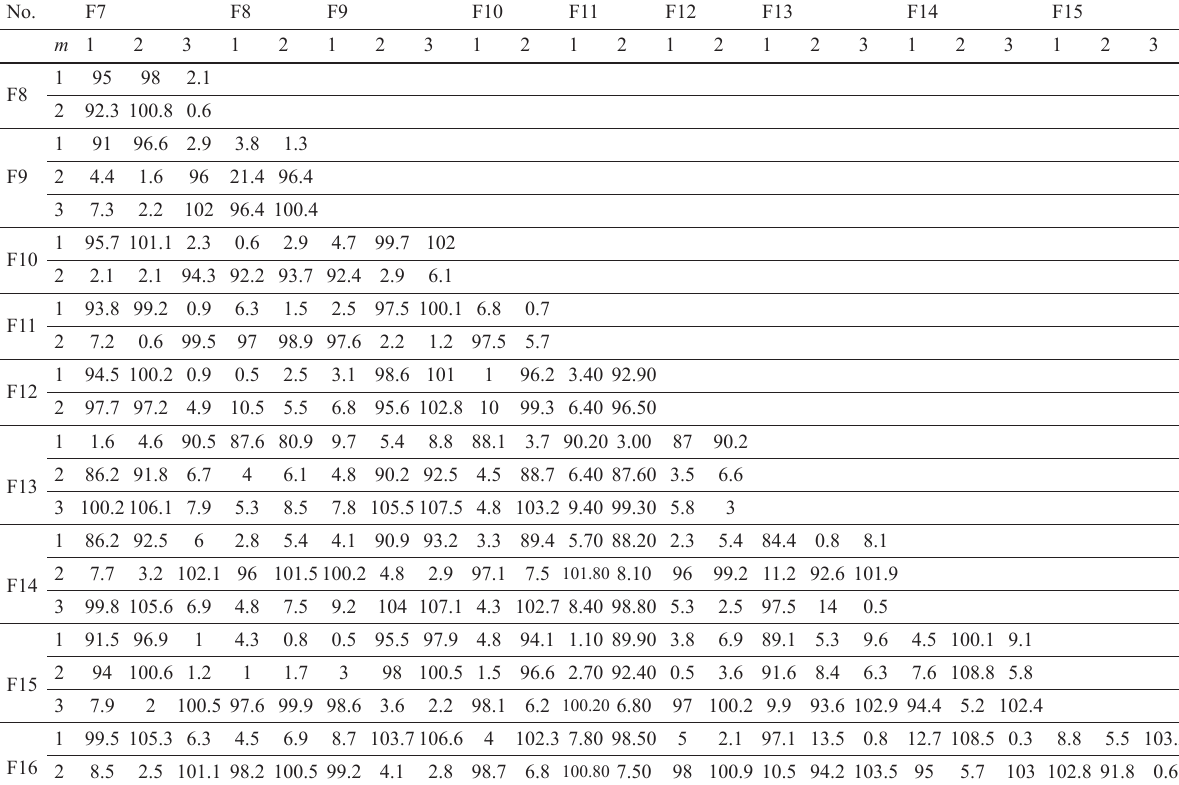
Table 6. Sensitivity analysis for parameter selection of SA-based GA No. Size Weight